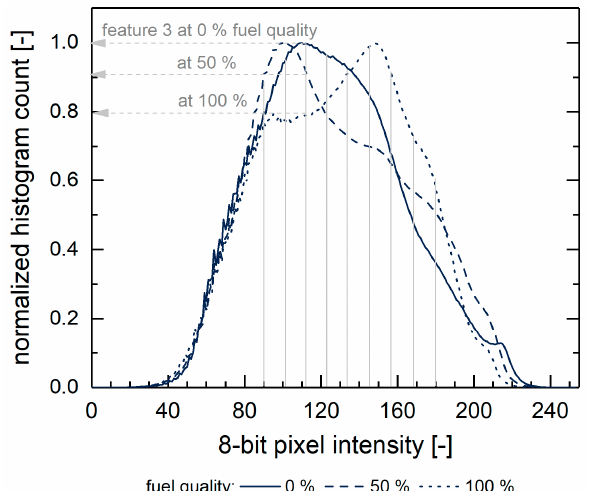
Figure 3. Averaged normalized histograms of 0%, 50% and 100% fuel quality classes, based on the greyscale image. Gray lines indicate the positions used for the feature vector formulation, exemplarily highlighting feature 3.